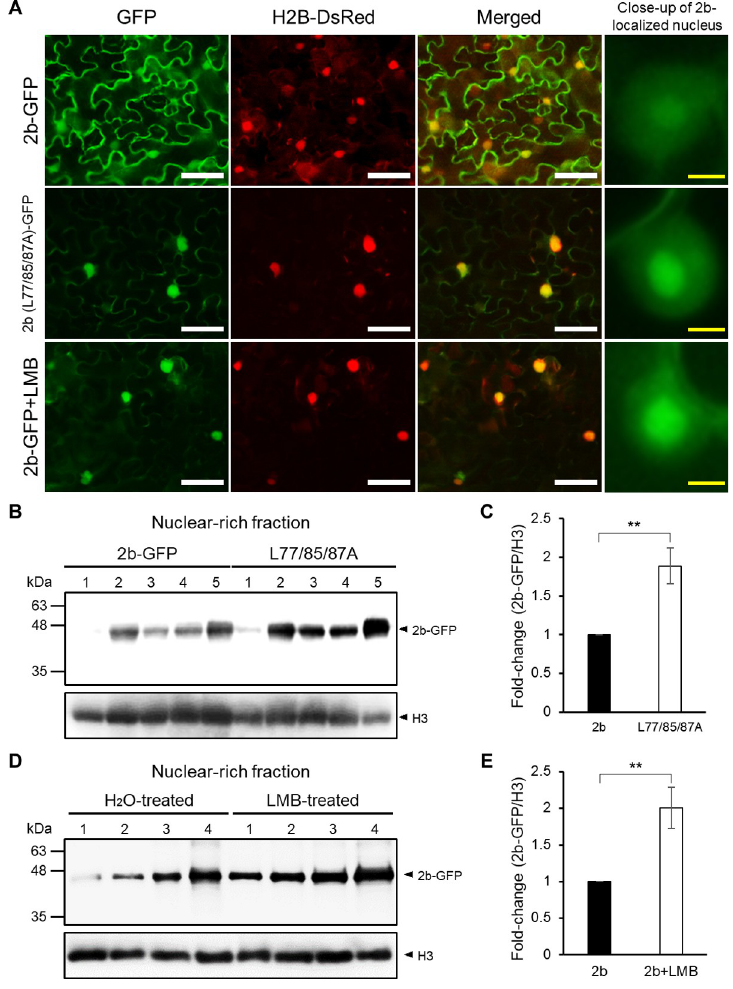
Fig 1. 2b has an NES motif for translocation from nucleus to cytoplasm. (A-E) Effect of a mutation in NES on the subcellular localization of 2b in N . benthamiana . The GFP-tagged wild-type 2b (2b-GFP) or L77/85/87A was co- expressed with Ds-Red-fused histone 2B (H2B-DsRed), a nuclear marker protein, in N . benthamiana by agroinfiltration. LMB (40 nM) was infiltrated into the leaves at 2 days post agroinfiltration. (A) GFP fluorescence was observed with an epifluorescence microscope at 4 h after the LMB treatment. Scale bar: 50 μ m (white), 5 μ m (yellow). (B) Western blot of nuclear-rich fractions to detect 2b-GFP. The numbers above the blot are 5 replicates, and the identical numbers below 2b-GFP and L77/85/87A-GFP indicate the same leaves were used. The histone protein (H3) was detected using anti-H3 antibodies as a loading control. (C) Relative 2b-GFP/H3 ratios were densitometrically calculated using Multi Gauge Software (Fujifilm) and shown as a fold change. Mean values ( ± SE) were tested on log- transformed data for a significant difference using Student’s t -test ( �� P < 0.01). (D) Western blot analysis using the nuclear-rich fractions to detect 2b-GFP from the LMB-treated leaves. The identical numbers above the blot indicate the same leaves used. (E) Relative 2b-GFP/H3 ratios in the H 2 O-treated and LMB-treated samples were densitometrically calculated using Multi Gauge Software (Fujifilm) and shown as a fold change. Mean values ( ± SE) were tested on log-transformed data for a significant difference using Student’s t -test ( �� P <